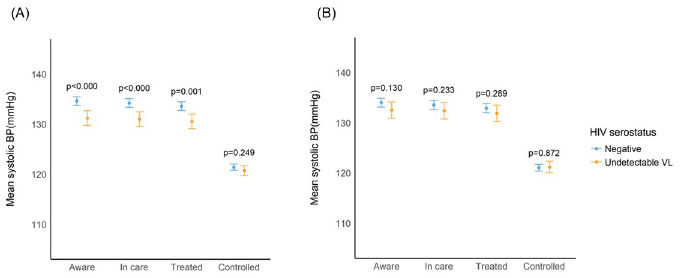
Fig 4. Mean predicted systolic blood pressure (SBP) among adults with hypertension in Umkhanyakude, Kwazulu-Natal, South Africa, according to HIV/ART status. A. Minimally adjusted predicted mean SBP. � Estimates adjusted for age and sex only and include inverse probability of sampling weights. B. Fully adjusted predicted mean SBP. � Estimates adjusted for age, sex, BMI, wealth tertile, education and smoking status and include inverse probability of sampling